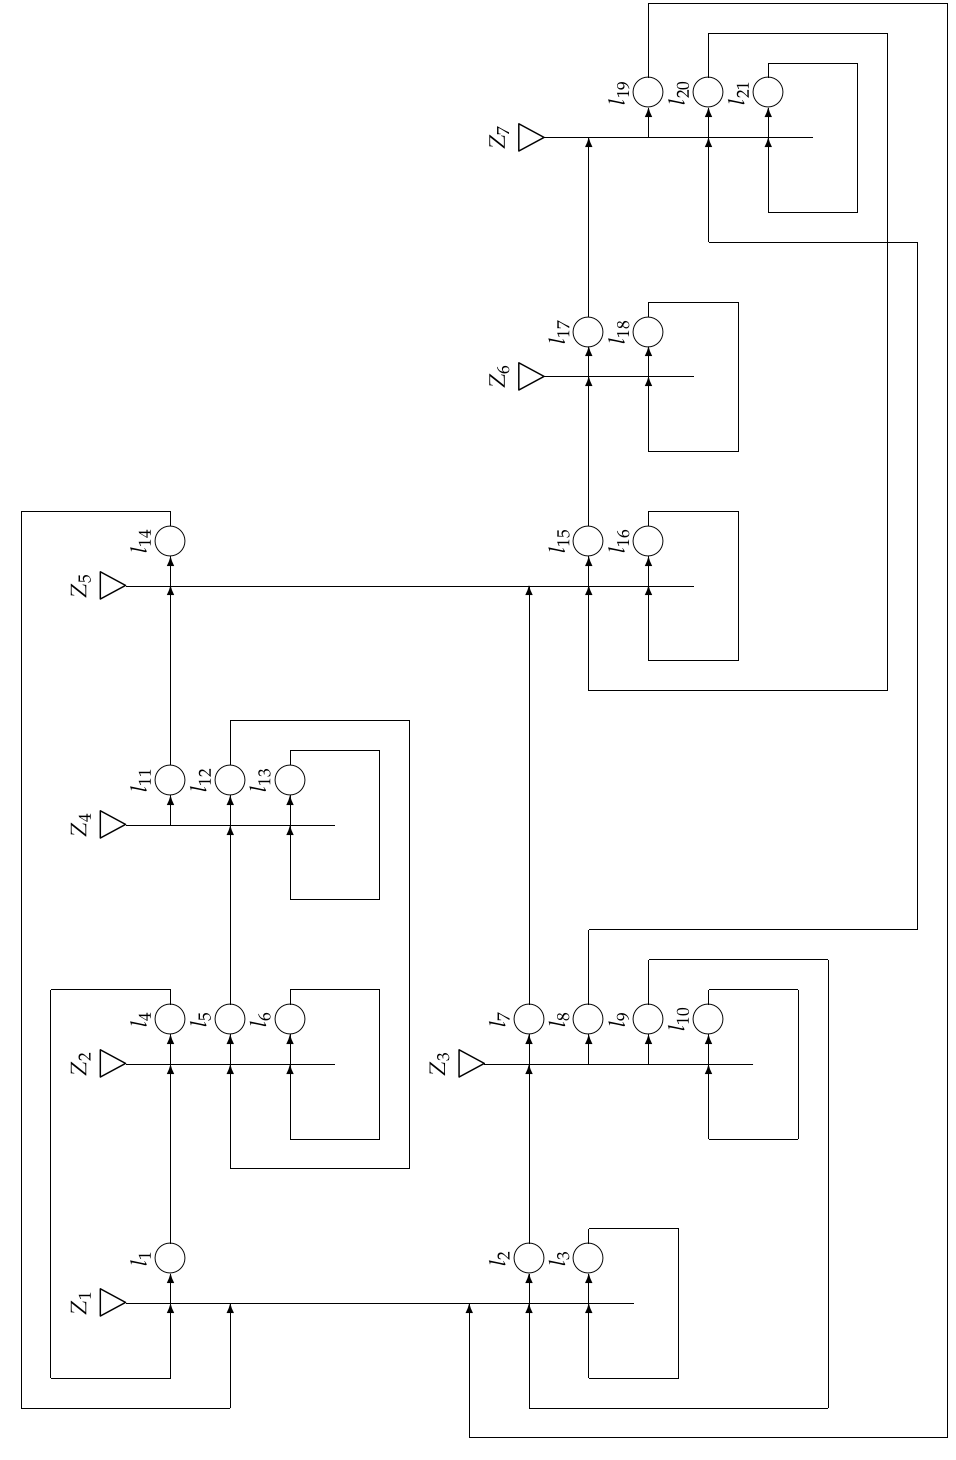
Figure 3. GN model for the description of the process of forest terrain monitoring for wildfire localization using